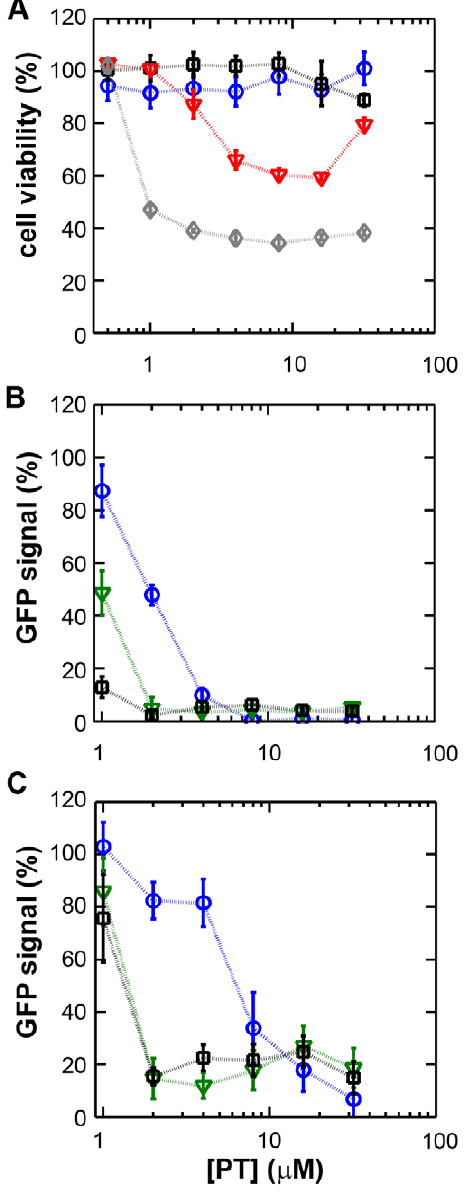
Figure 1. The zinc ionophore pyrithione inhibits nidovirus replication in cell culture. ( A ) Cytotoxicity of PT in Vero-E6 cells in the absence (blue circles) or presence of 2 (black squares), 4 (red triangles), or 8 m M (gray diamonds) ZnOAc 2 as determined by the MTS assay after 18 hours of exposure. ( B ) Dose-response curves showing the effect of PT and Zn 2 + on the GFP fluorescence in Vero-E6 cells infected with a GFP-expressing EAV reporter strain at 17 h p.i. Data were normalized to GFP expression in infected, untreated control cultures (100%). The different Zn 2 + concentrations added to the medium were 0 (blue circles), 1 (green triangles), or 2 m M ZnOAc 2 (black squares). ( C ) Effect of PT and Zn 2 + on the GFP fluorescence in Vero-E6 cells infected with a GFP-expressing SARS-CoV reporter strain at 17 h p.i. Data were normalized to GFP expression in infected untreated control cells (100%). Colors for different Zn 2 + concentrations as in Fig. 1B. Error bars indicate the standard deviation (n=4).